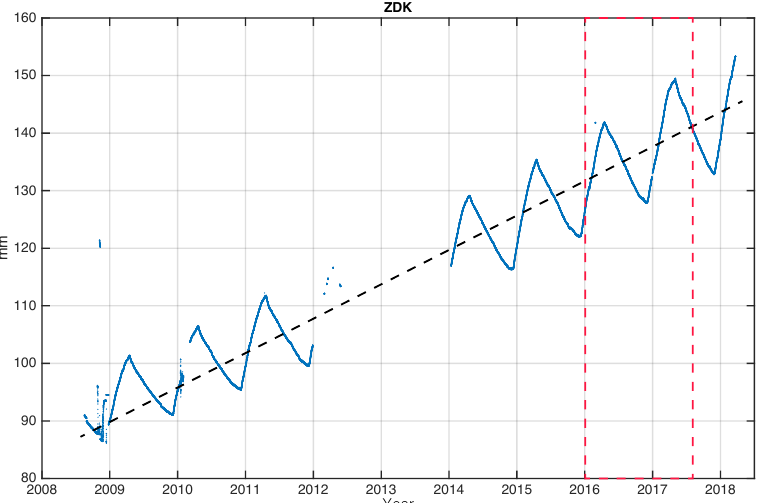
Figure 15. Groundwater level variation of the well station ZDK. The location of this station has been given in Figure 12. Red dotted line denotes the time span for the Sentinel data acquisition. Vertical axis denotes the measured values, which is contrary to the actual groundwater